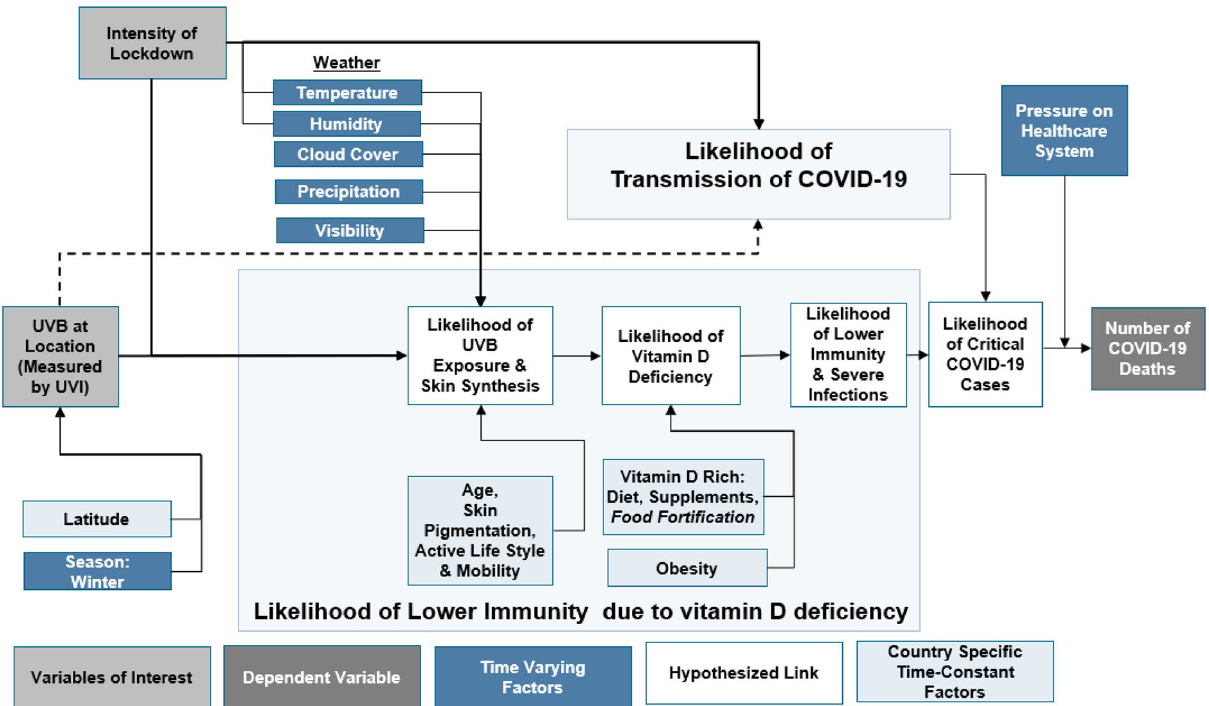
Figure 1. Explanation of the Association of Severity of Lockdown & UVB Radiation with Cumulative COVID- 19 Deaths. Note We extended the theoretical framework of the protective role of UVB radiation in reducing COVID-19 deaths from Moozhipurath et al. 8 .